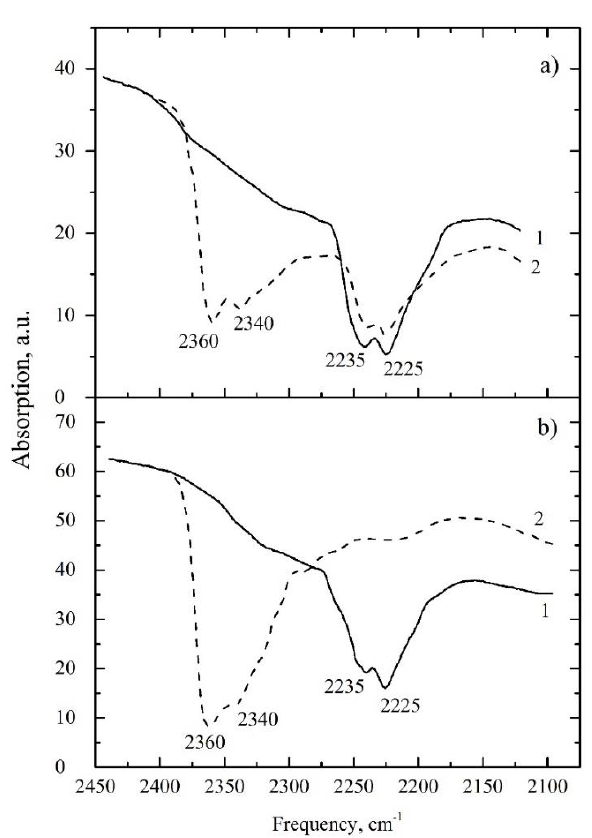
Figure 4. IR spectra of N 2 O adsorbed on TS-1 (Si/Ti = 14.4) ( a ) and TS-1 (Si/Ti = 32) ( b ) at 300 K (1) and upon heating the samples at 570 K for 1 h with pre-adsorbed N 2 O (300 K) (2).